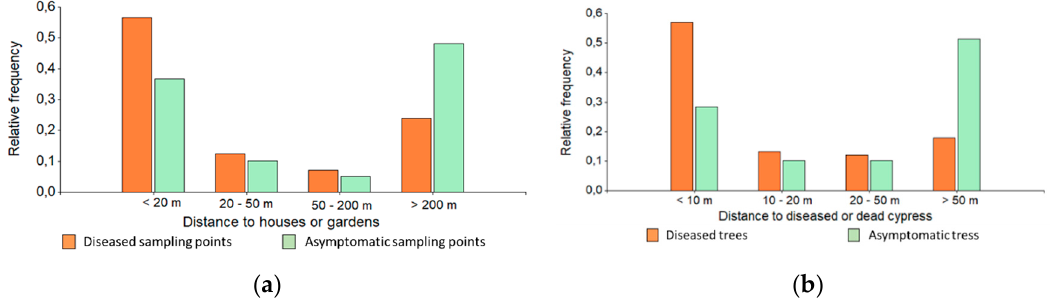
Figure 7. ( a ) Relative frequency of diseased and asymptomatic field sampling spots according to the distance to houses or irrigated gardens. ( b ) Relative frequency of diseased and asymptomatic field sampling trees according to the distance to a diseased or dead tree.